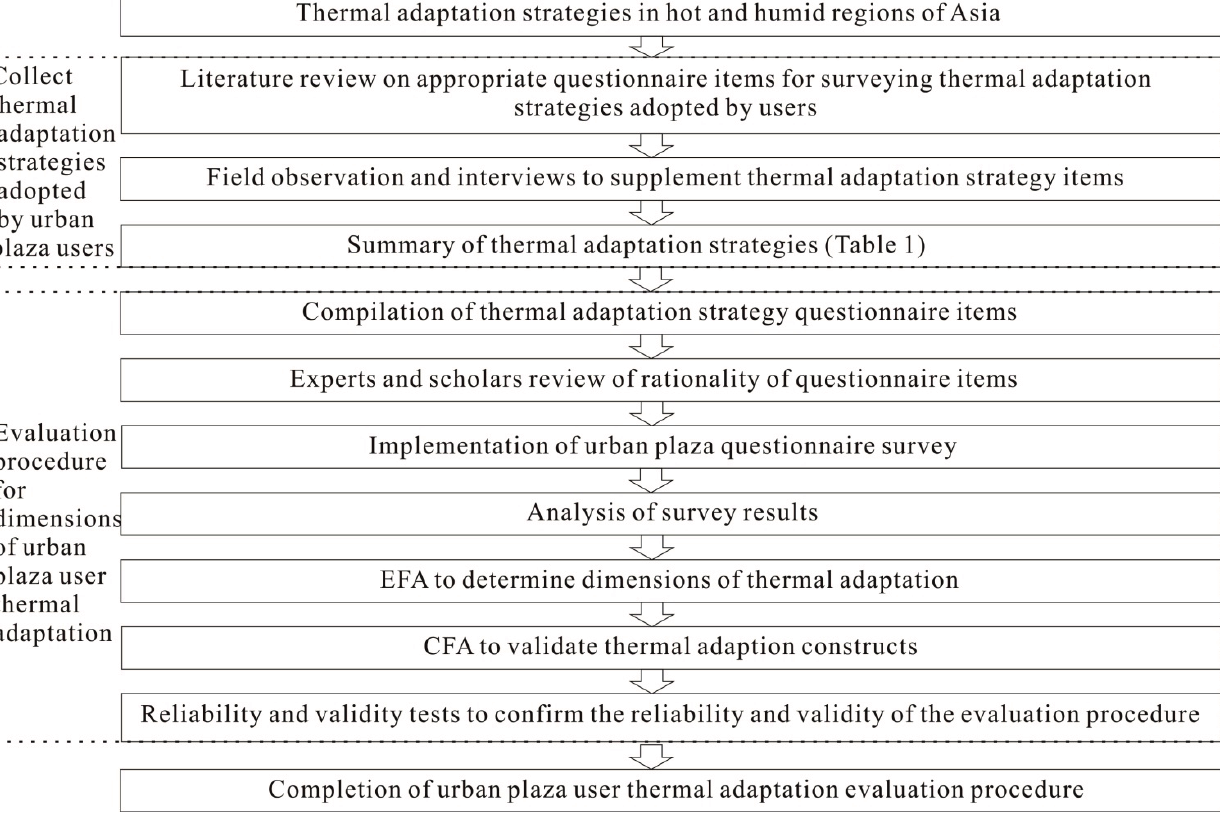
Figure 2. Establishing the thermal adaptation evaluation procedure of urban plaza users in hot and humid